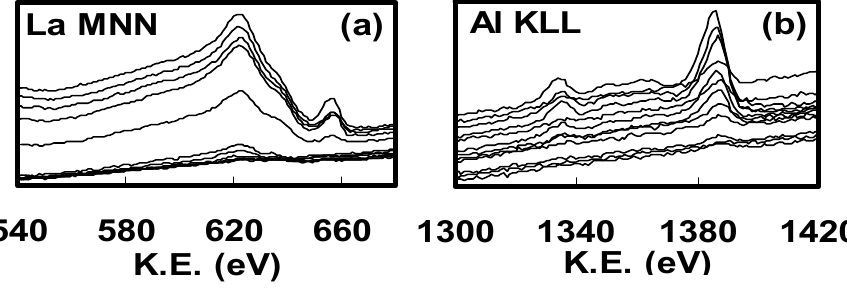
Figure 31. Dependence of La/(La+Al) on the position on the wafer.